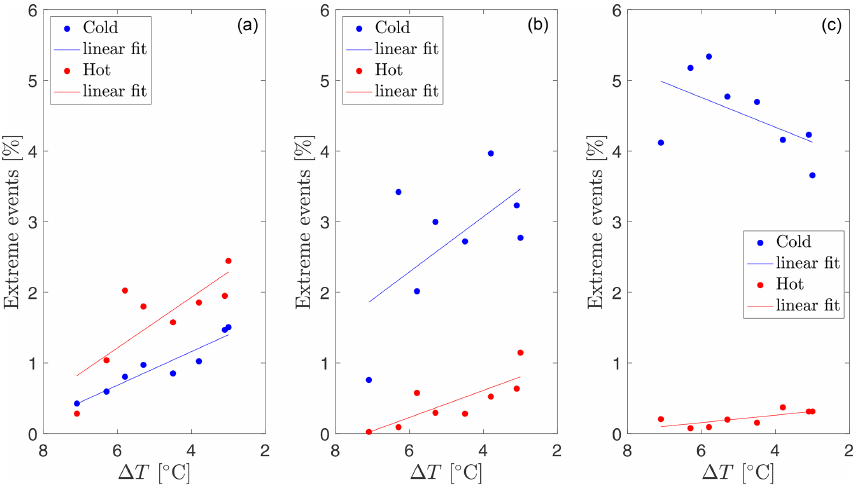
Figure 9. Trend of the cold (blue) and hot (red) extreme events with decreasing Equator–pole temperature difference. The trends are consid- ered at three latitudes in the plot: polar latitude (a) , mid-latitude (b) , and subtropical latitude (c) . The three latitudes are indicated in Fig. 10 by the labels p, m, and e, respectively.